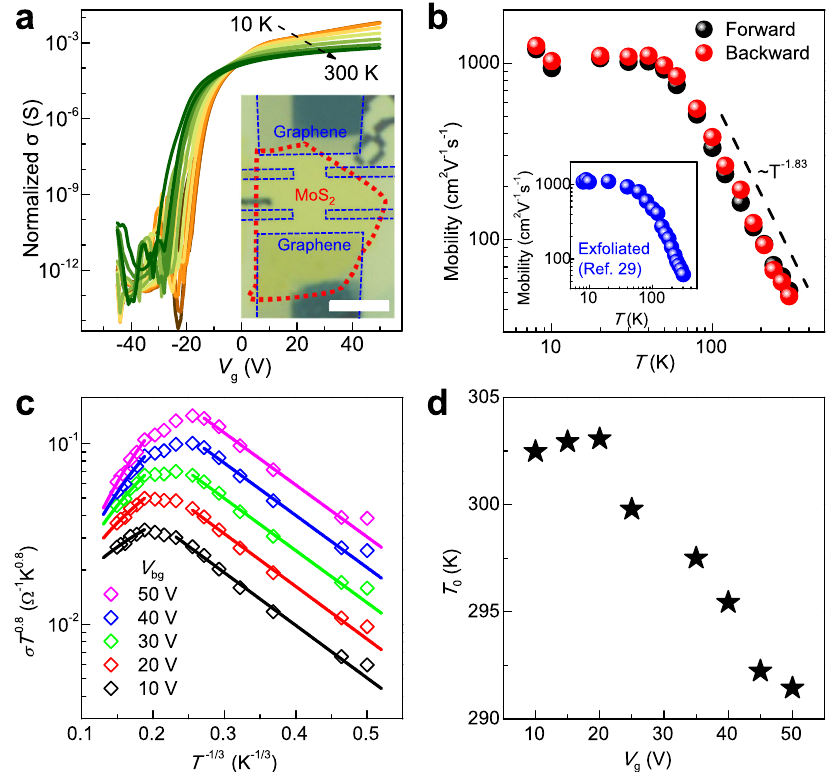
Fig. 4 Electrical measurement for a typical as-etched 4L MoS 2 encapsulated by ultraclean h-BN dielectrics. a Transfer characteristics for the as-etched 4L MoS 2 at various different T values of 10, 30, 50, 80, 120, 180, 240, and 300 K. Inset: Optical image for the BN/Graphene/MoS 2 /BN structure where graphene (labeled by dashed blue lines) is used as the electrodes for MoS 2 channel (dashed red lines) in the standard Hall geometry. Scale bar, 4 μ m. b T -dependent fi eld-effect mobility. At T > 60 K, the mobility follows the power law μ / T (cid:1) γ with γ = 1.83. The black dashed line ( (cid:3) T (cid:1) 1 : 83 ) is a guide to the eyes. Inset: μ (cid:1) T curve of a typical mechanically exfoliated multi-layer MoS 2 . Adapted with permission from ref. 29 . Copyright 2015 American Chemical Society. Our etched sample exhibits comparable performance to exfoliated counterparts. c T -dependent normalized conductance at various gate voltages. At low T regime the carrier transport can be described by Mott VRH model, while it turns into the band-like transport behavior at high T regime. d Values of characteristic temperature ( T 0 ) estimated from the Mott VRH model at low T regime versus gate voltage. The values are rather small, indicating that the disorder due to Al residues is insigni fi